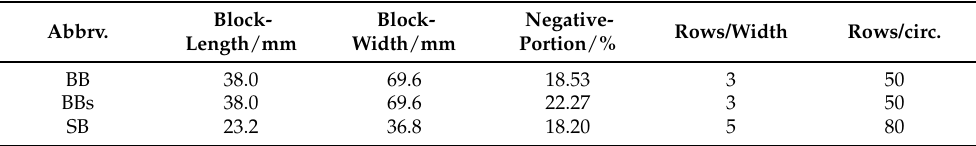
Table A1. Length and width of the tread blocks, as well as negative void of the whole pattern and number of block rows in lateral and longitudinal direction. Pattern BBs has the same external dimensions as BB, but due to the 0.5 mm width of the sipes, it has a slightly larger negative pattern void